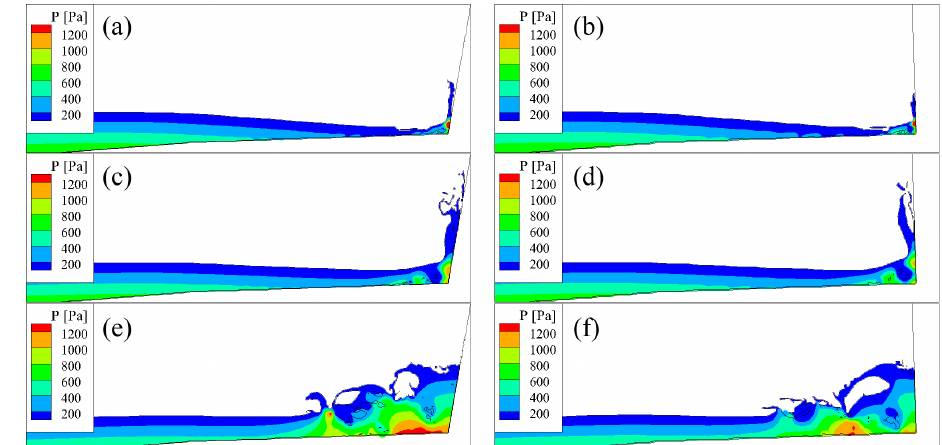
Figure 12. Snapshots of impact pressure distribution in front of the cliff. (a, c, e) case12; (b, d, f)